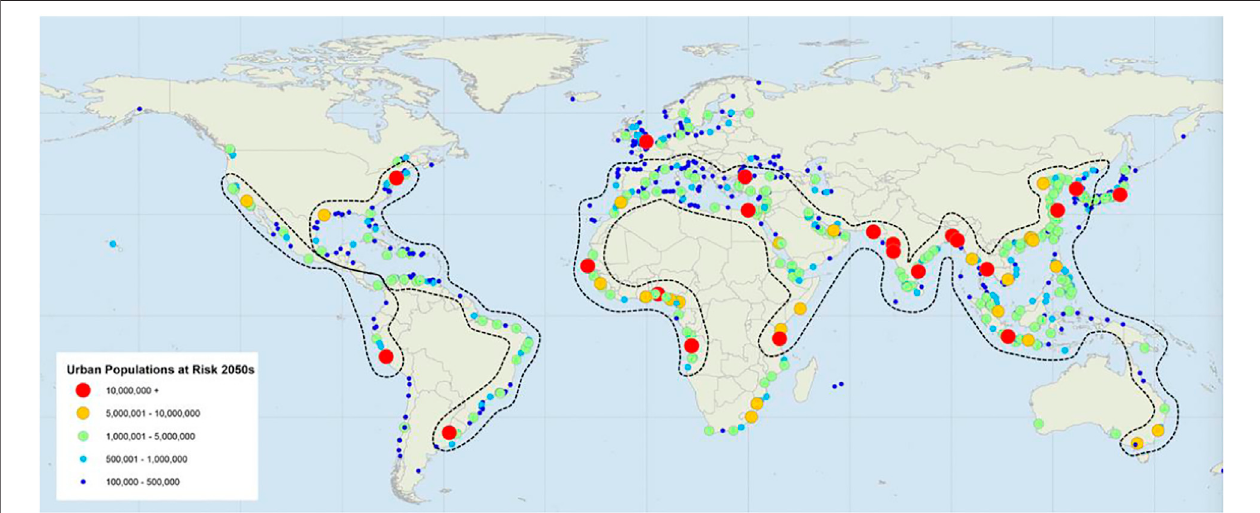
FIGURE1 | Colored dots show coastal cities that will be signi fi cantlyimpacted bysea-levelrise.Note thatmany ofthe largest cities are on lowerincometropical to sub-temperate coasts (C40.org, 2020). Coastal zones enclosed in the highlighted area will experience multiple climate stresses that will interact with other mega-trends that will lead to diminished resilience and sustainability (Modi fi ed from C40 2020. Reprinted by permission).